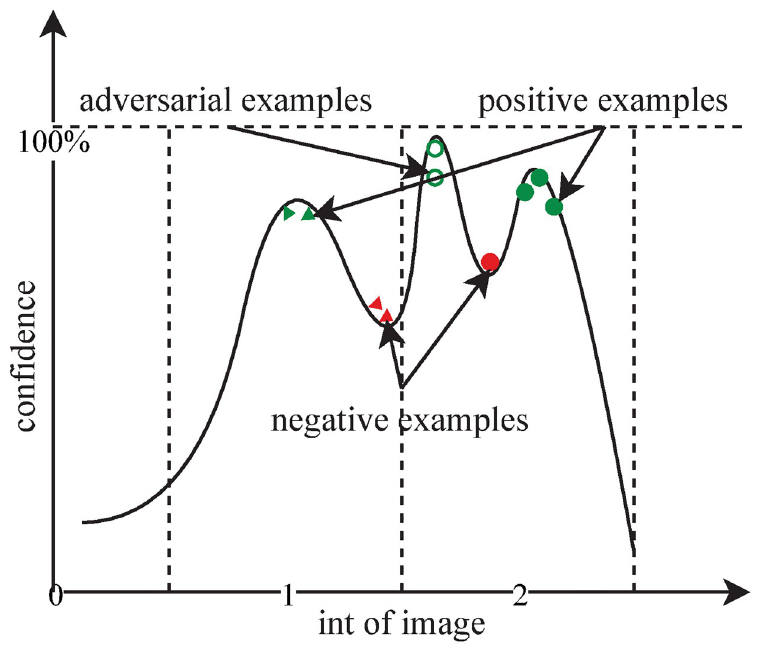
Fig 10. The confidence curve of a binary